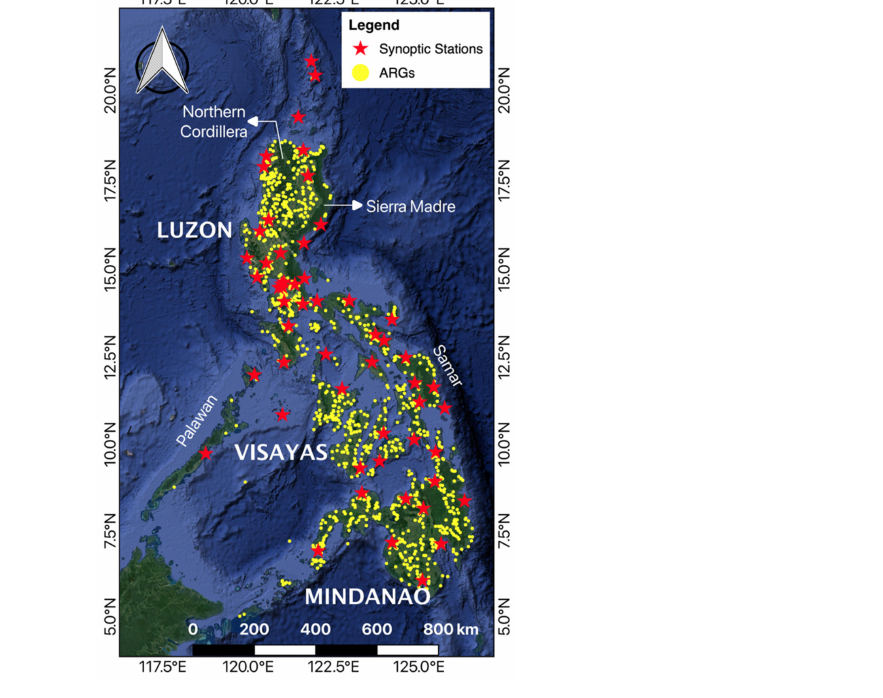
Figure 1. Locations of synoptic stations (red) and ARGs (yellow) over the Philippines as of